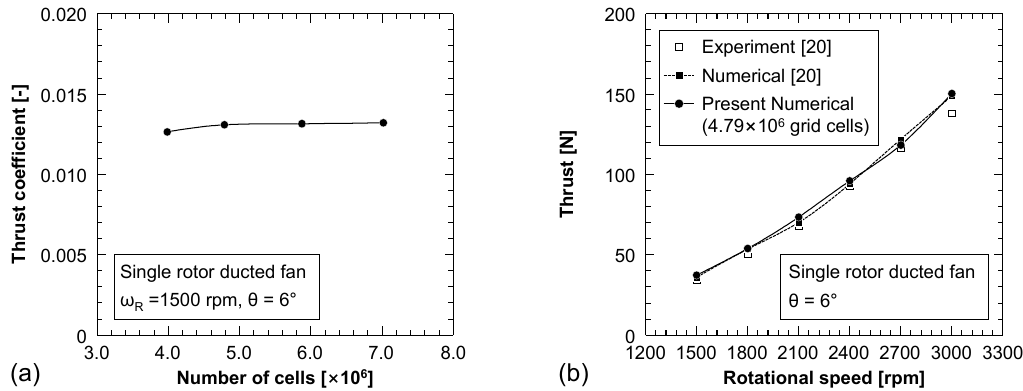
Figure 3. ( a ) The thrust coefficient for different grid systems, and ( b ) comparison of thrust on single rotor ducted fan of the present numerical study with the experiment and numerical results of Akturk and Camci [20].